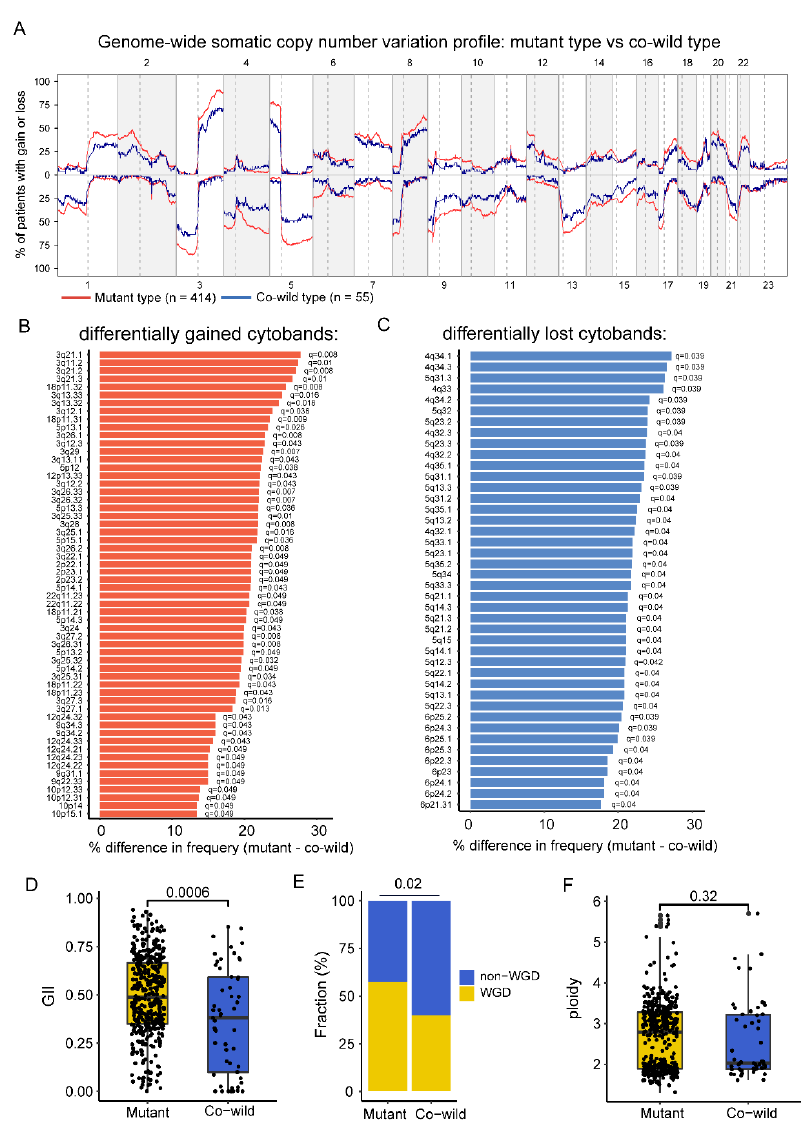
Figure 4. The somatic copy-number alteration profile of TP53 / LRP1B mutant and co-wild LUSC. ( A ) The genome-wide somatic copy number variation profile in TP53 / LRP1B mutant and co-wild LUSC. ( B ) The significant difference in gained cytobands between TP53/LRP1B mutant and co-wild LUSC. ( C ) The significant difference in lost cytobands between TP53/LRP1B mutant and co-wild LUSC. ( D – F ) The GII, WGD, and ploidy difference between TP53/LRP1B mutant and co-wild LUSC.